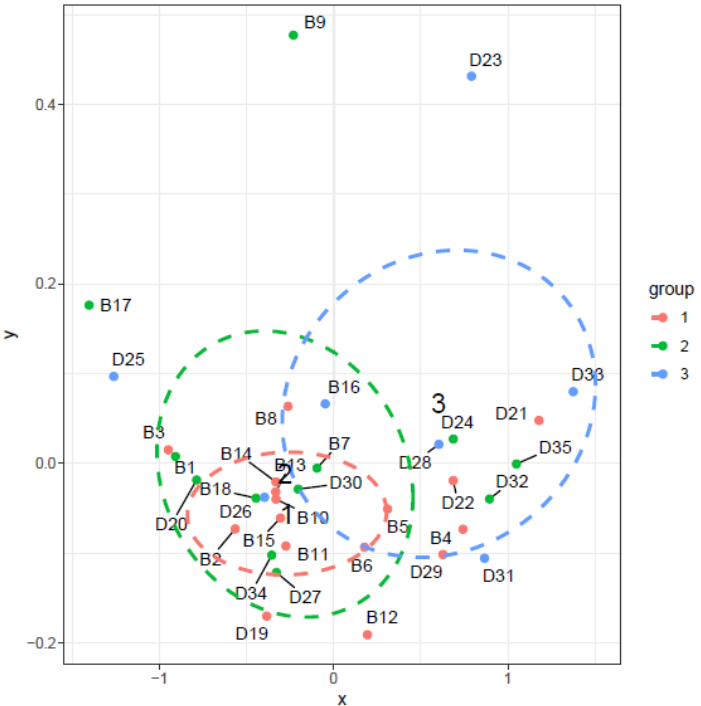
Figure 20. NMDS visualizing the level of similarity for the factor—windows opening during cleaning activities.